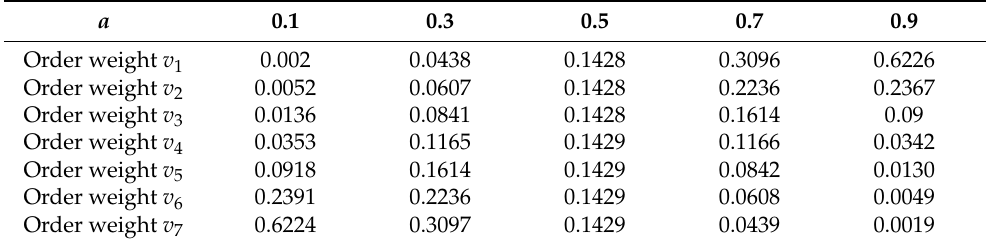
Table 2. The order weights of the evaluation index under different a